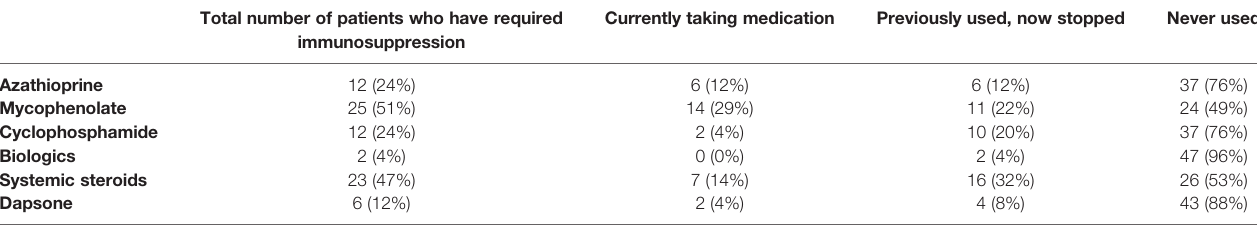
TABLE 2 | Details of medications/systemic immunotherapy of the 49 OcMMP patients (percentages are based on the total number of OcMMP patients recruited to the study, denominator = 49). Total number of patients who have required immunosuppression